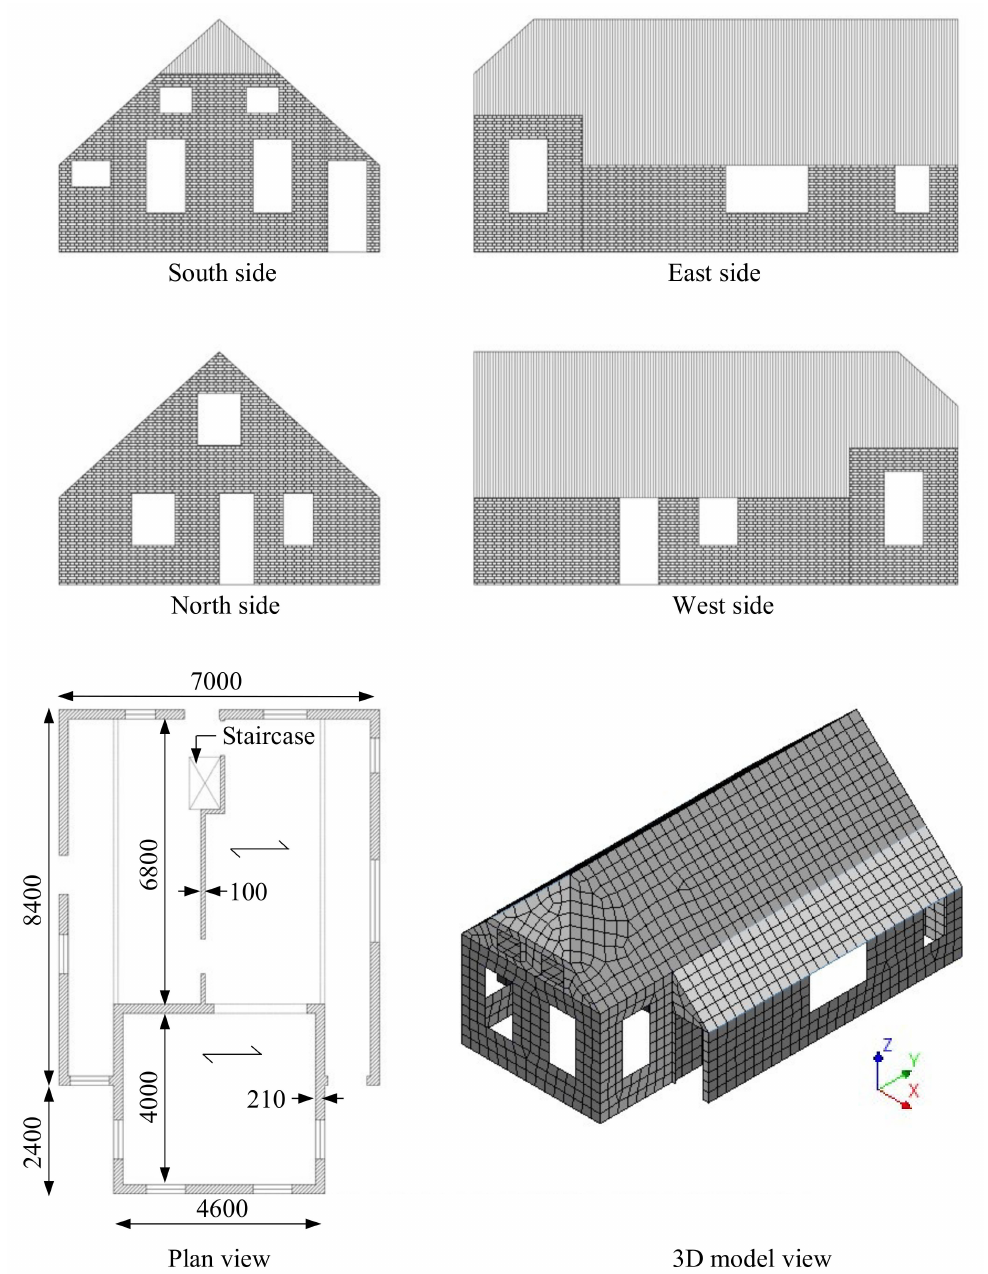
Figure 6. Main properties and geometry of the first case–study building B1 (dimensions in